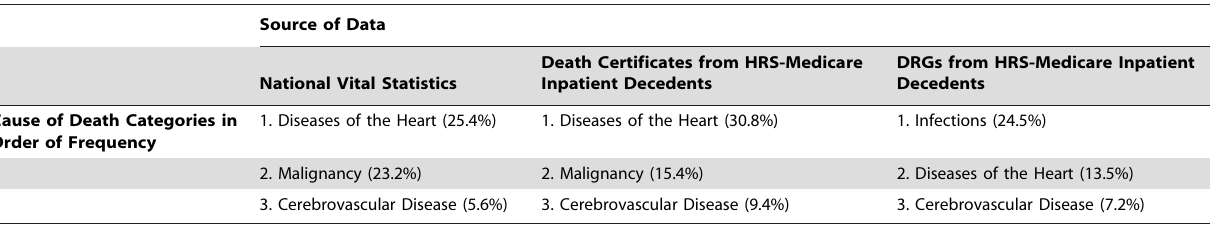
Table 3. Top 3 Causes of Death: National Vital Statistics 2007 vs Death Certificates vs DRG.